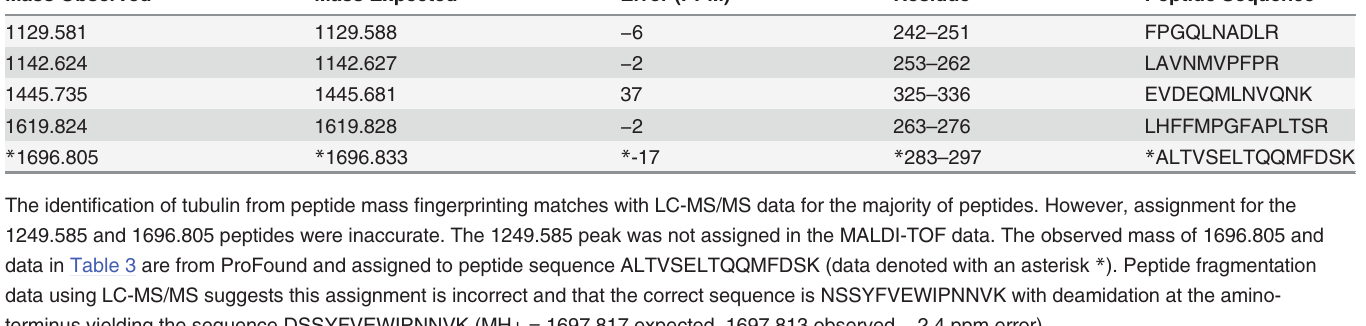
Table 3. Beta-Tubulin identification and limitations of peptide mass fingerprinting. Mass Observed